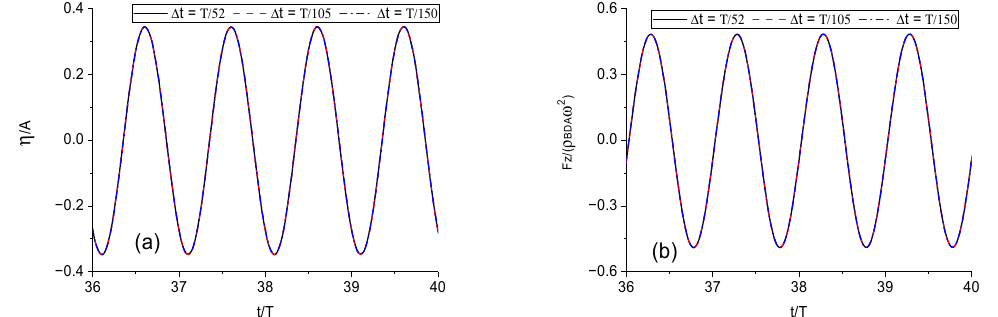
Figure 5. Convergence study with time step: ( a ) wave runup on the right side of the body; ( b ) vertical force on the body.